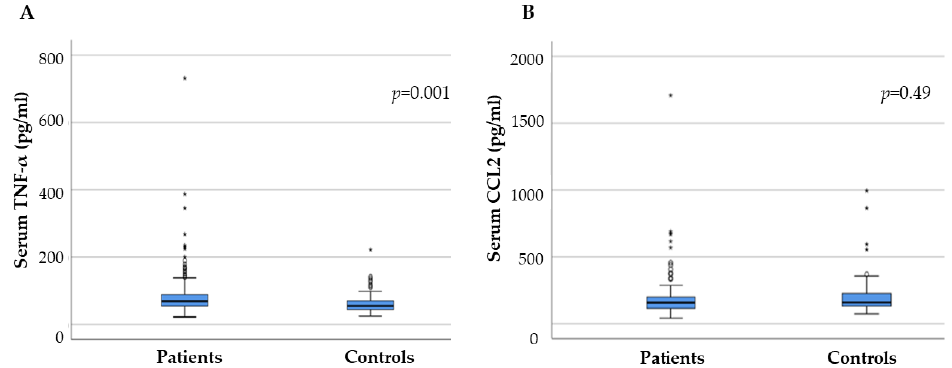
Figure 1. Serum levels of ( A ) TNF-a and ( B ) CCL2 in patients and controls. PD patients had significantly higher serum TNF ( p = 0.001) levels compared with controls. The median level of CCL2 in the serum of PD patients did not differ significantly from the control group ( p = 0.3). * represents the extreme values.